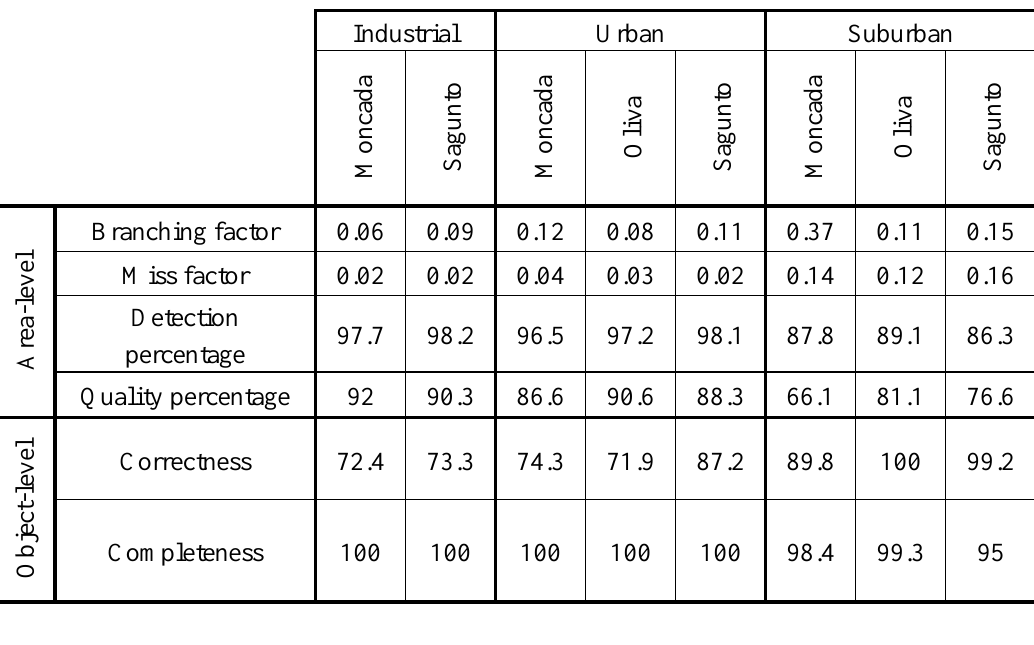
Figure 6. Detection examples of industrial buildings in Sagunto (a) , urban buildings in Oliva (b) and suburban buildings in Moncada (c) using the thresholding-based